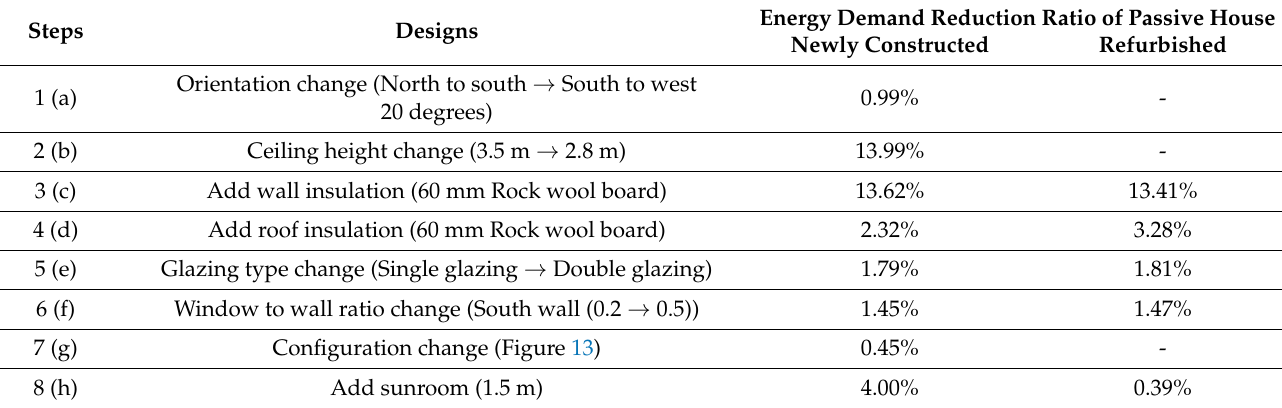
Table 10. Energy demand reduction ratio of each passive design